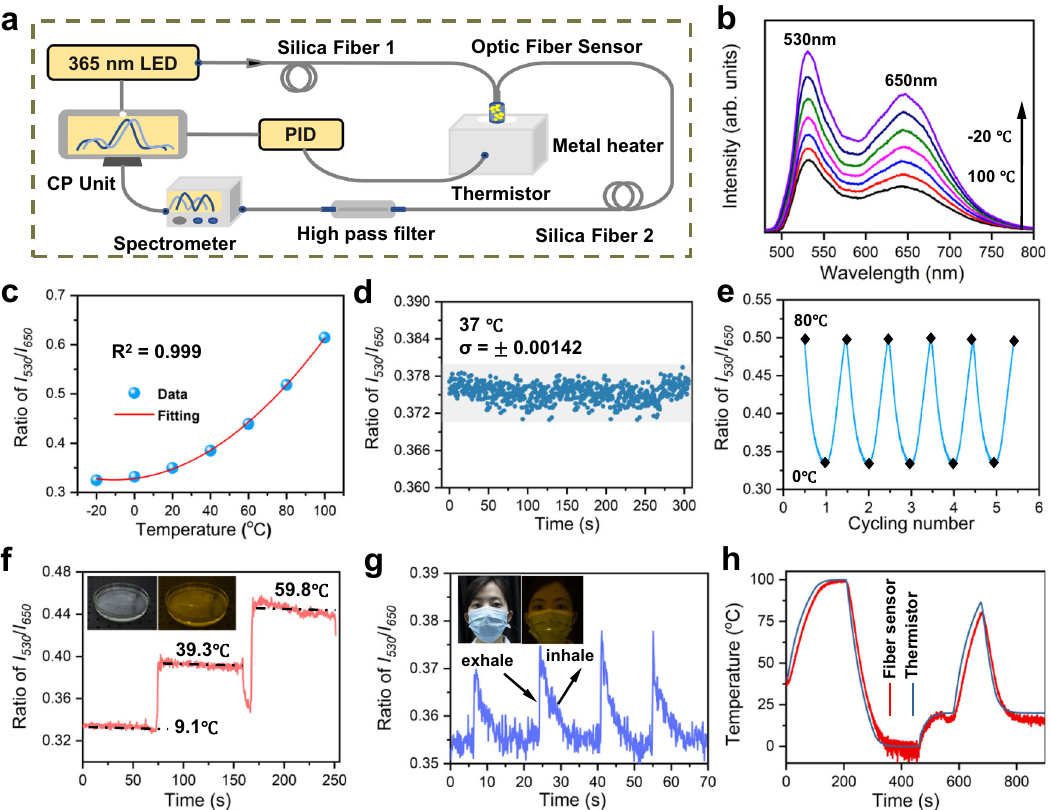
Fig. 5 Performances of the wearable optical fi bre temperature sensor. a Schematic diagram of the optical fi bre sensor based on fl uorescence sensing platform. CP unit: Controlling and processing unit. PID: proportional-integral-derivative. b Fluorescence responses of the Li 2 Zn 0.85 SiO 4 :0.15Mn 2 + integrated optical fi bre sensor to temperature ranging from – 20 to 100 o C with an interval of 20 o C. c Emission intensity ratios of I 530 / I 650 versus the temperature. I 530 and I 650 at a given temperature are calculated based on the integrated emission intensity from 520 – 540 nm and 640 – 660 nm, respectively. d Fluctuations of the optical sensor output over time at the constant temperature of 37 o C. e Temperature cycling test of the optical fi bre sensor between 0 – 80 o C. f Monitoring the change of water temperature with time by using the as-fabricated optical sensor. The inset shows the photograph of the water-temperature measuring by using the fi bre sensor. g Monitoring the temperature change of the exhale and inhale with time by using the as-fabricated optical sensor. The inset displays the photograph of temperature change detection of the exhale and inhale of a volunteer by using the fi bre sensor fi xed on the mask. h Tracking the response time of a commercial thermistor and the fabricated optical fi bre